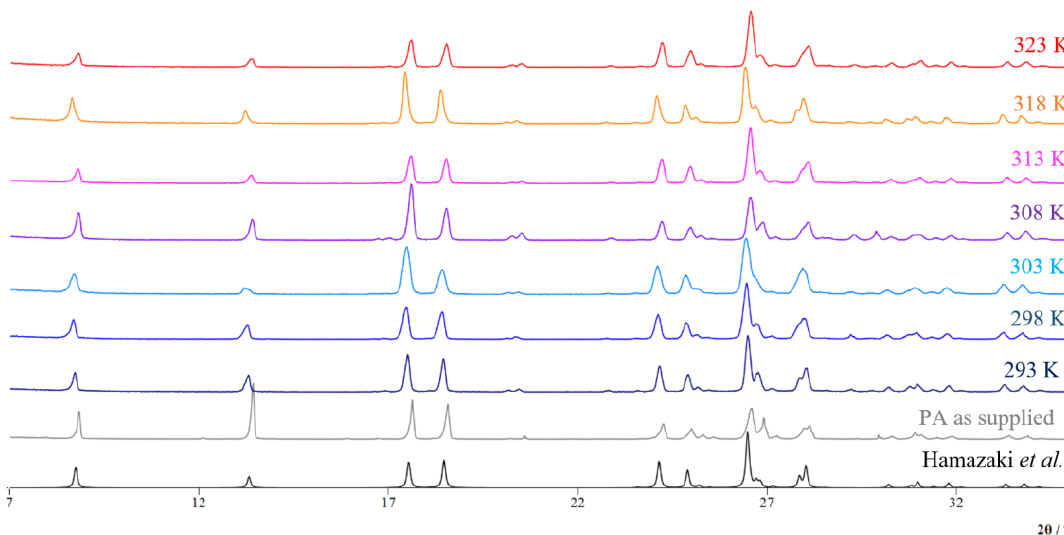
Figure 7. Comparison of X-ray diffraction patterns obtained at 293 ± 2 K for solid forms in equilibrium with the saturated PA acetonitrile solutions stabilized for one week at different temperatures. The PA as supplied (gray), and the pattern estimated from the SCXRD structure found in the literature [11] (black), are also plotted. All the diffractograms were normalized to the peak of highest intensity ( I n ) and plotted using EasyGraphII [19].